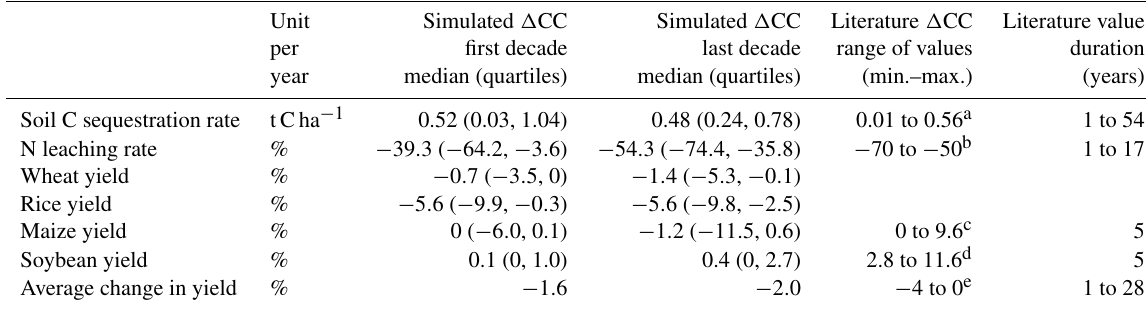
Table 1. Simulated responses to cover crops (CC) in comparison to the control scenario with bare fallow (REF) on cropland during main-crop off-season periods as annual aggregated area-weighted median and in the parentheses the quartiles (Q1, Q3) for the first and last decades of the 50-year simulation period (see Sect. 2.5 for equations used). In the last two columns values from other studies as well as their considered duration of cover crop management are